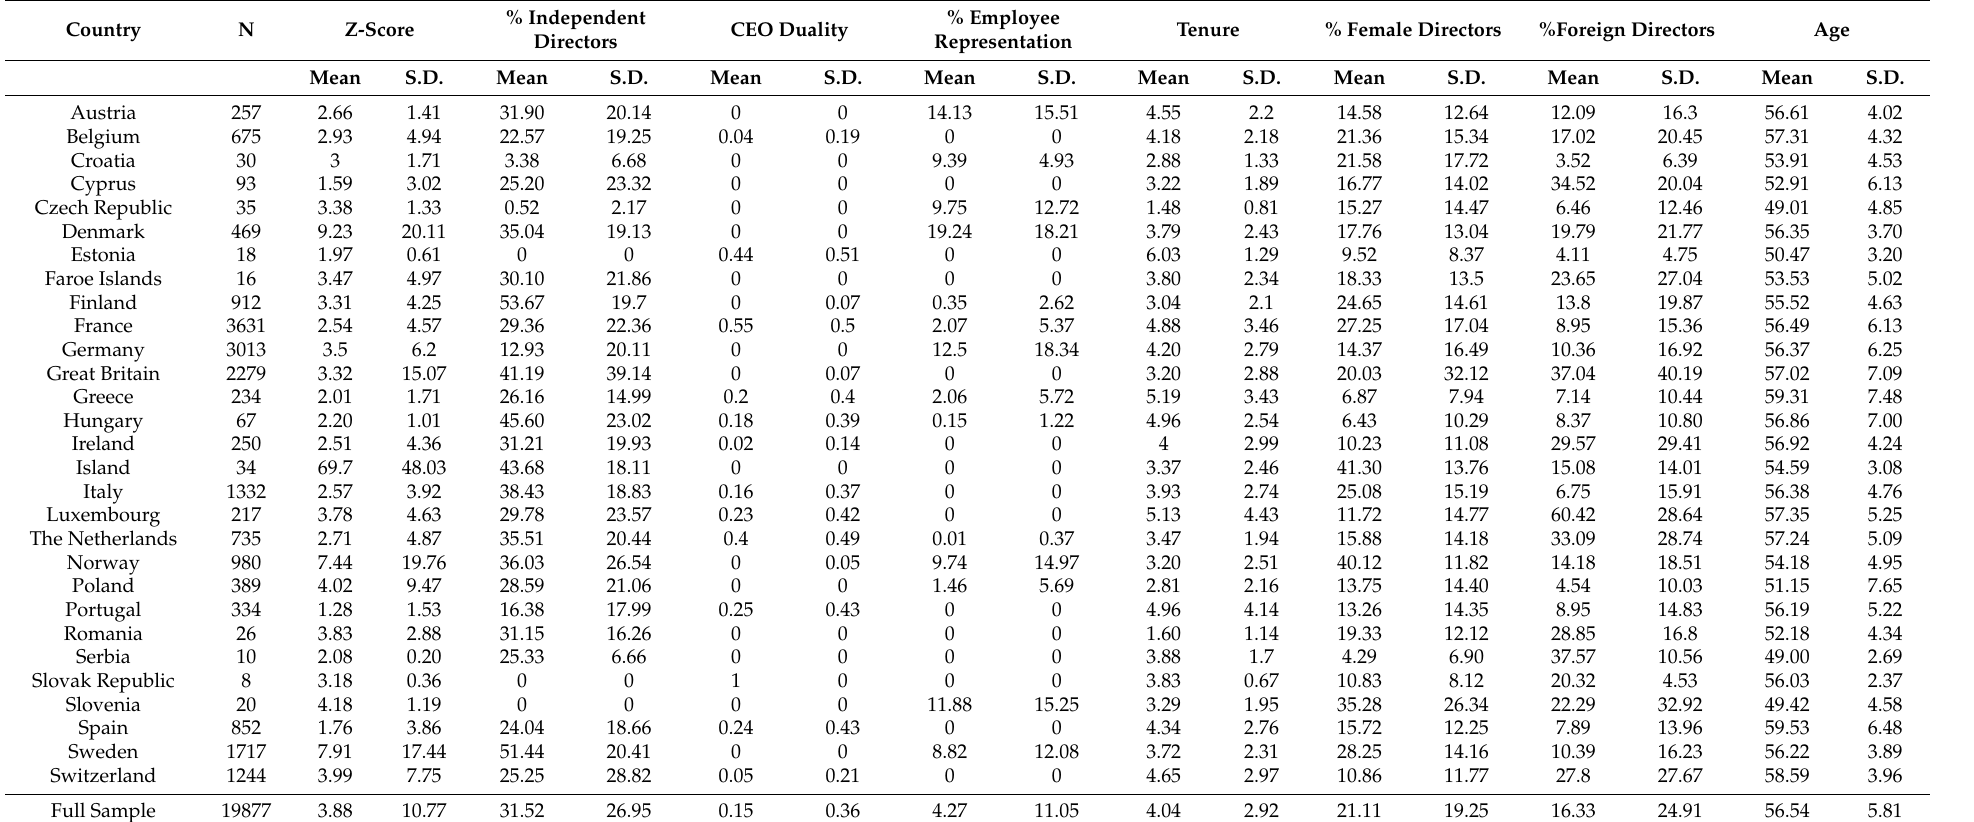
Table 2. Z-Score and Board